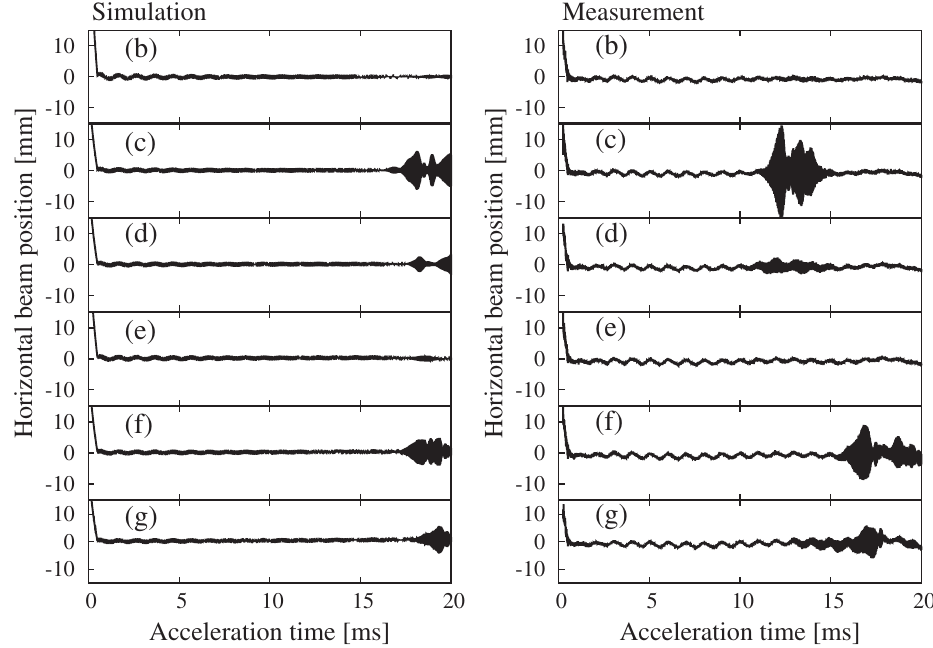
FIG. 23. Simulated (left) and measured (right) results of beam instability dependence on ν x manipulations [Figs. 19(b) – 19(g)], for 1 MW beam power, when only a quarter of the full chromaticity correction at injection by using dc × 0 . 25 field was applied. With a very severe beam instability at 1 MW, the simulation results show the necessity of a proper choice of ν x manipulations in order to suppress the beam instability. Simulated and experimental results were found to be consistent in all